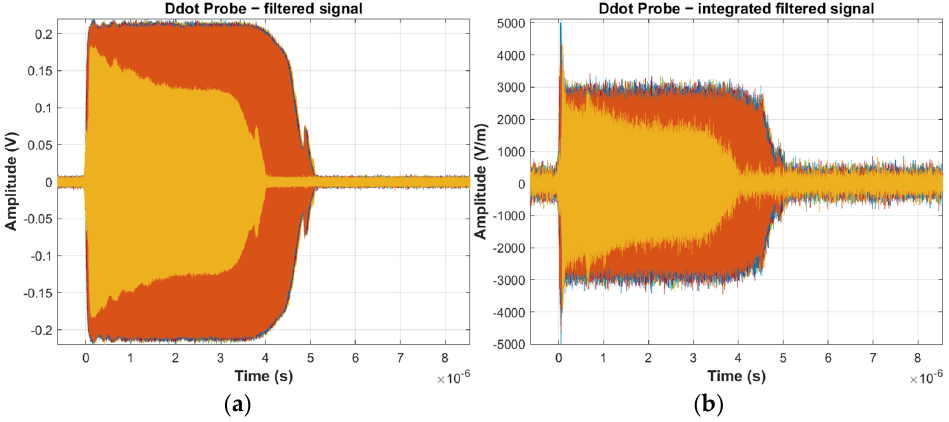
Figure 15. An example of electric field measurement signal, raw filtered signal from D-dot probe ( a ), integrated filtered signal from D-dot probe ( b ).